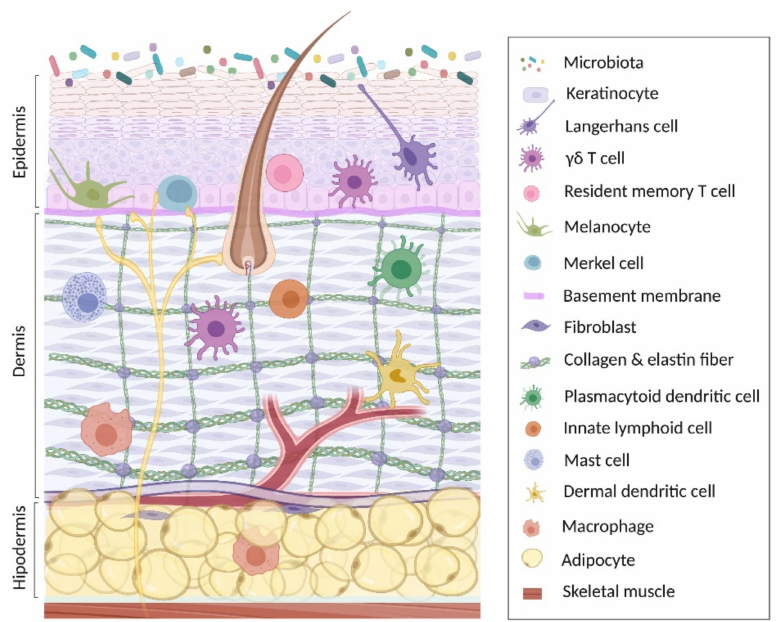
Figure 1. Anatomy of the skin. This image represents the three main layers of the skin, including the most abundant cellular populations in each layer, together with the immune cells present in each anatomical region. Created with BioRender.com (access date: 26 August